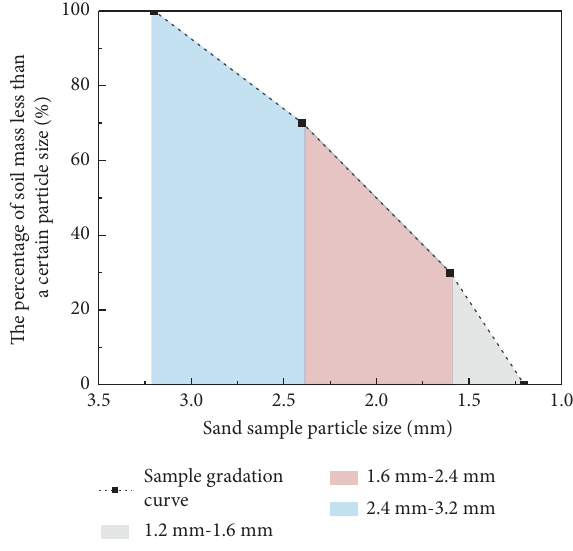
Figure 3: Sand specimen